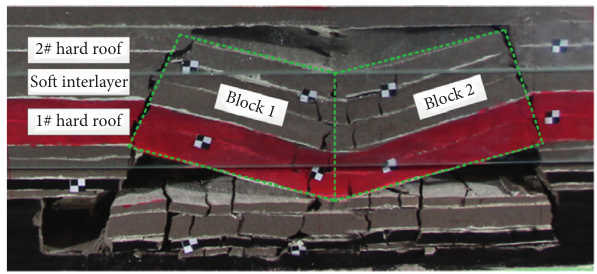
Figure 5: Face advance